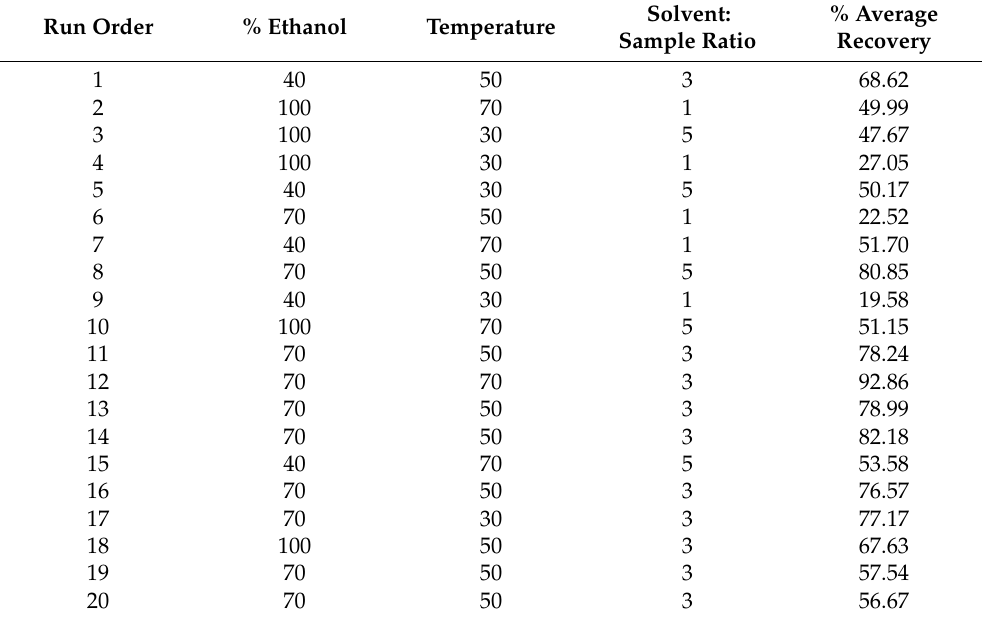
Table 2. CCD experimental conditions and response for optimization of the extraction method.